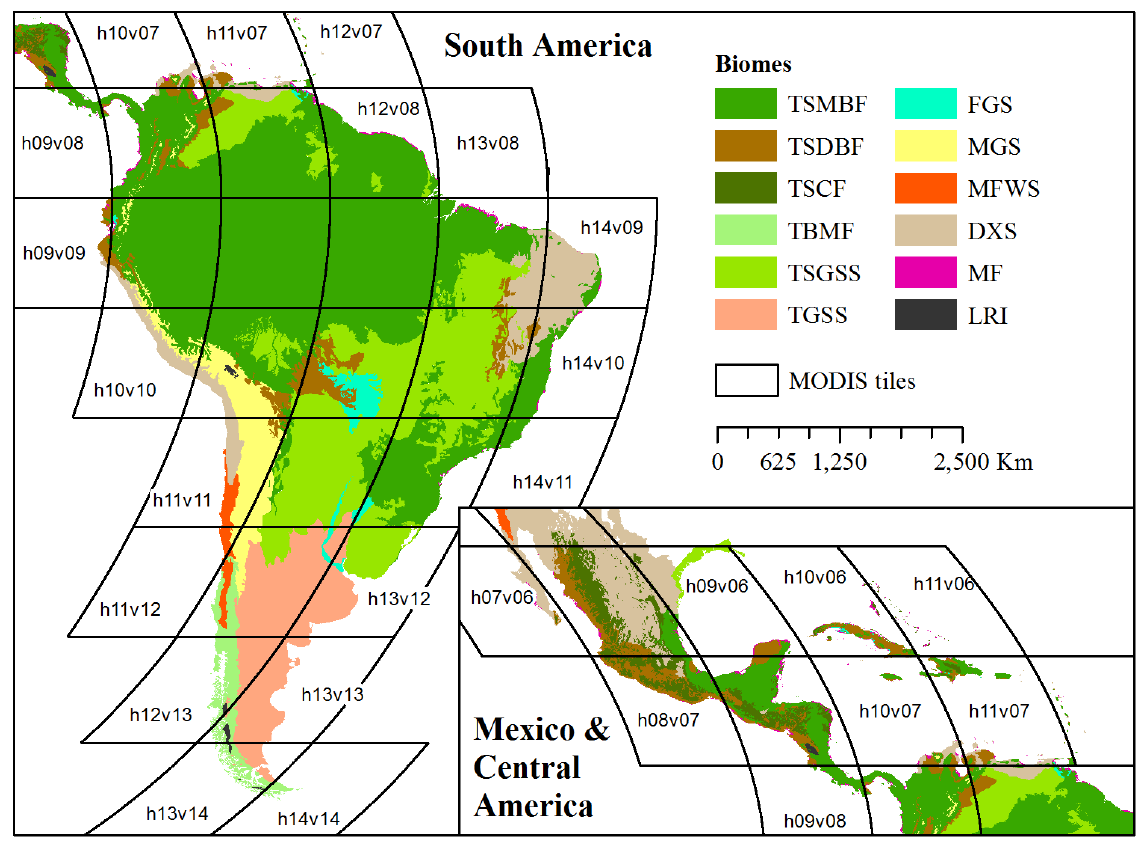
Figure 4. Biomes [14] and MODIS tiles covering Latin America and the Caribbean. See Table 2 for full names of biome